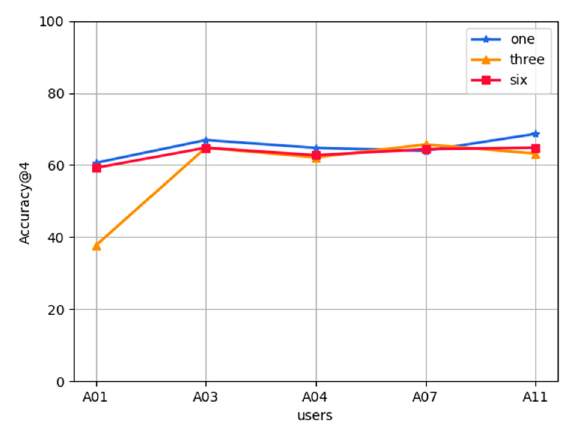
Figure 9. Effect of user data size on FL-AHNEAP.